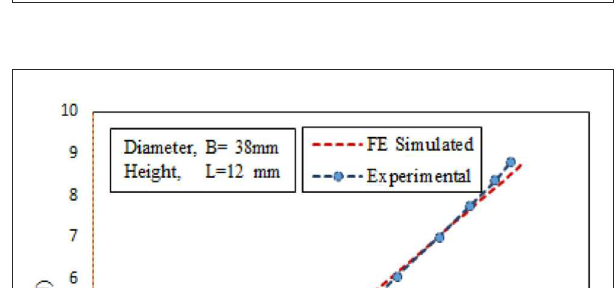
FIGURE1 Load vs. displacement graph for PVA-C model with 5% concentration.